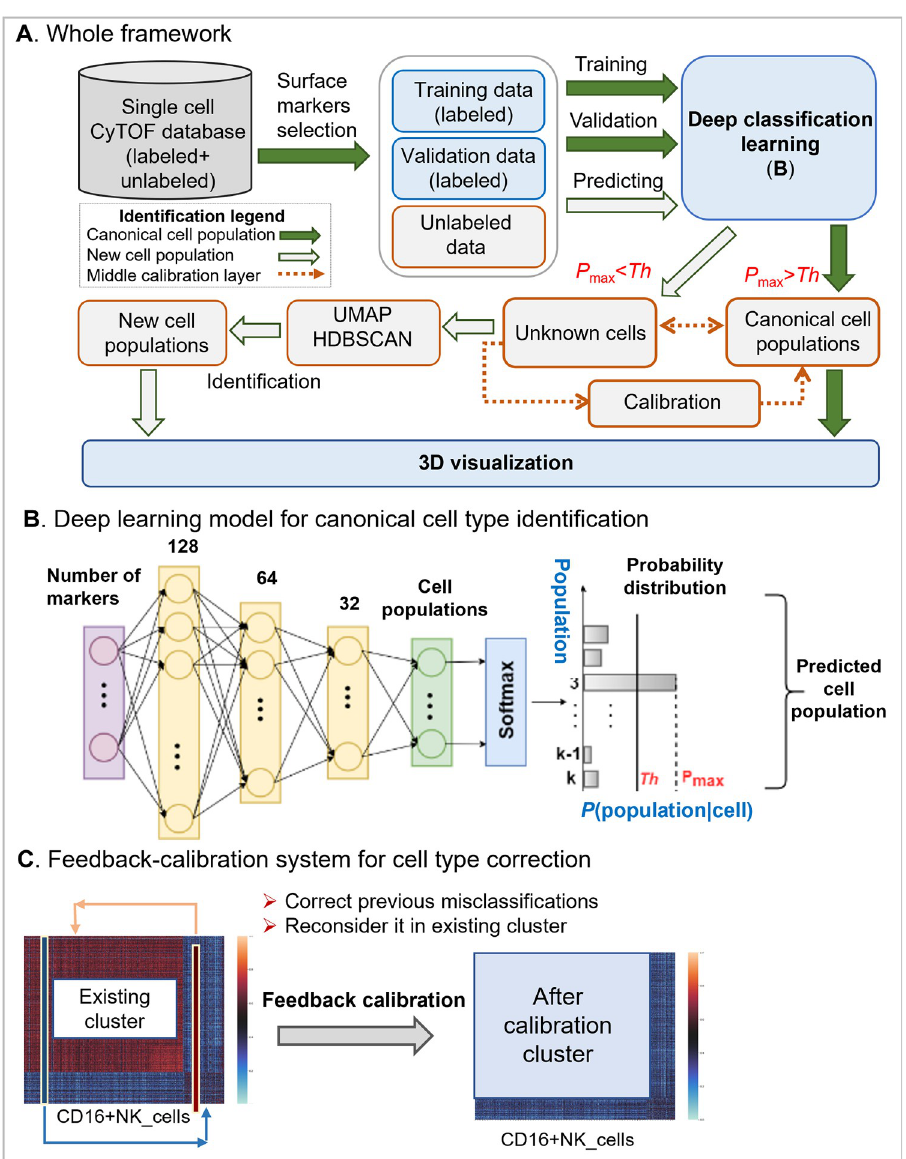
Fig 1. A framework of DGCyTOF model in the identification of canonical cell population and new cell type populations. A ) The flowchart of DGCyTOF. To single cell data, it includes labeled and unlabeled data in CyTOF database. Identification of cell types includes four processes. (1) To cells labeled, a supervised deep learning automatically identifies canonical cell populations or cell types gated by protein markers, the detailed description sees ( B ). (2) To new cell population, a novel graphic-clustering integrating UMAP + HDBSCAN allows a learning of feature representations and preservation of data structure in a network of cell-to-cell interaction for the assignment of clusters for identification of new cell populations. (3) These cell types from classification and clustering are adjusted between (1) and (2) layers above mentioned via a feedback-loop using an iteration calibration system to reduce false-negative errors in the system integrating cell identification. (4) In the final step, a tool permitting three-dimensional (3D) visualization is developed to display the cell clusters, projecting all cell type labels into independent 3D space for their vivid depiction and differentiation to facilitate the identification of cell types. B ) A three-layer artificial neural network constructs the deep classification-learning model for the identification of canonical cell populations. C ) A calibration- feedback learning system for cell type correction. After deep learning model in Fig 1A, there are lots of known cell types identified (here called existing cluster). A correlation threshold value averaging the Spearman correlation determines whether the cell belongs to these known cell population. If correlation of the filtered cell with cells from the given canonical cell population is greater than the correlation threshold in this population, we reallocate that cell to this canonical